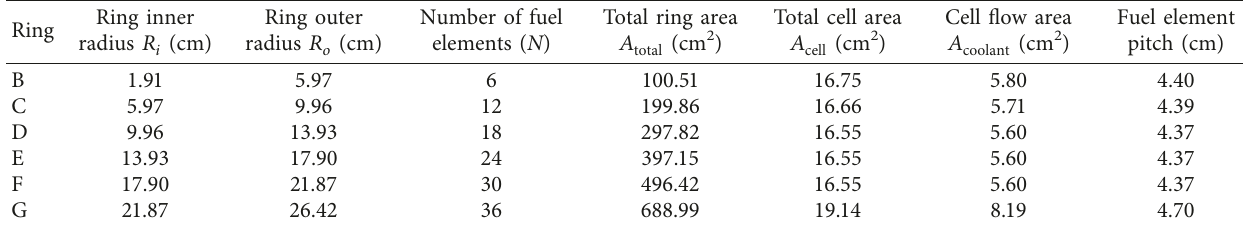
Figure 5: Generated power in each fuel element at reactor full power. Table 1: GSTR fuel ring and flow cross-sectional